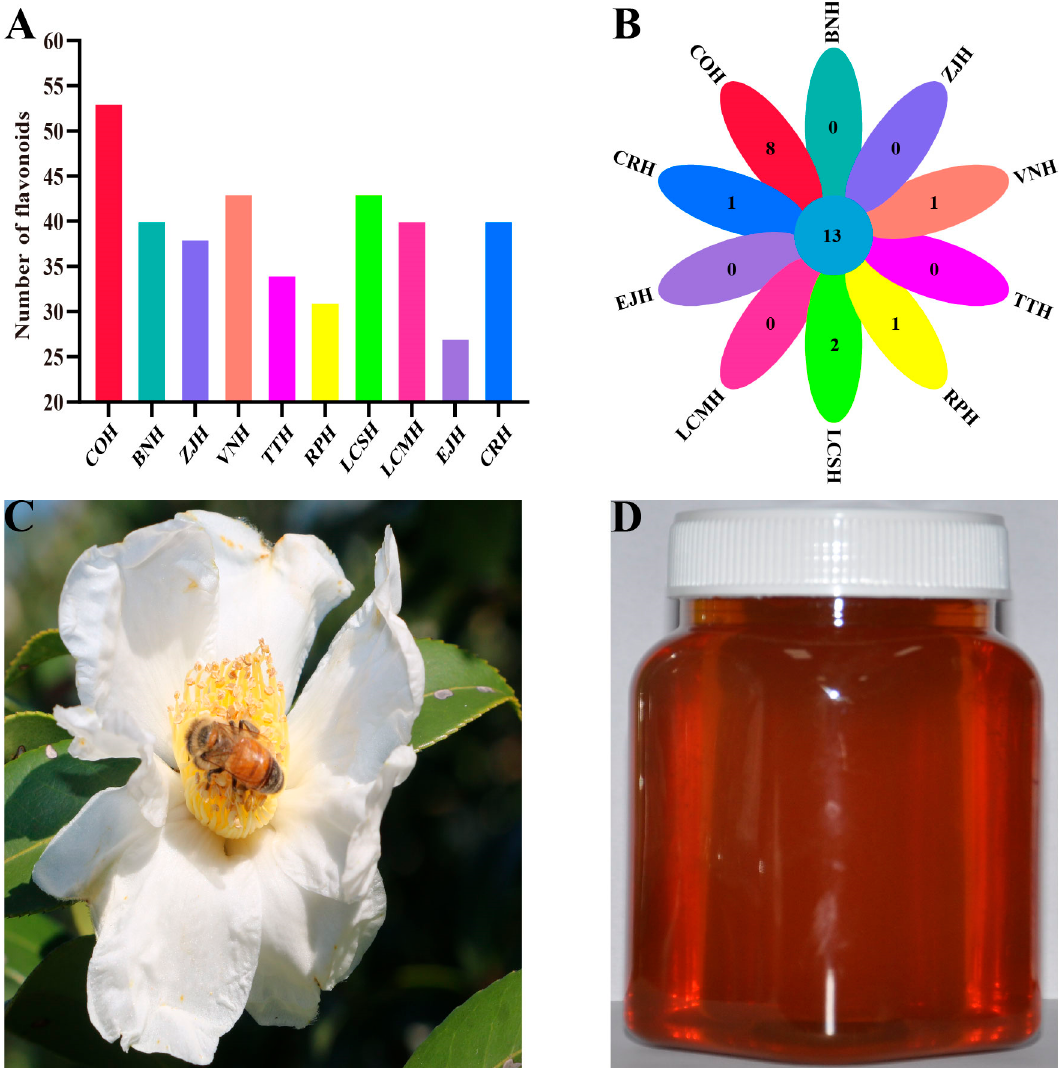
Figure 1. ( A ) Flavonoid species identified in C. oleifera honey and 9 monofloral honeys. C. oleifera honey (COH), Citrus reticulata honey (CRH), Vitex negundo honey (VNH), Eriobotrya japonica honey (EJH), Litchi chinensis Sonn honey (LCSH), Lycium chinense Miller honey (LCMH), Ziziphus jujuba honey (ZJH), Tilia tuan honey (TTH), Brassica napus honey (BNH), Robinia pseudoacacia honey (RPH). ( B ) Flavonoid species distinctive to C. oleifera honey relative to 9 monofloral honeys. ( C ) Honeybee-visited C. oleifera . ( D ) C. oleifera honey.